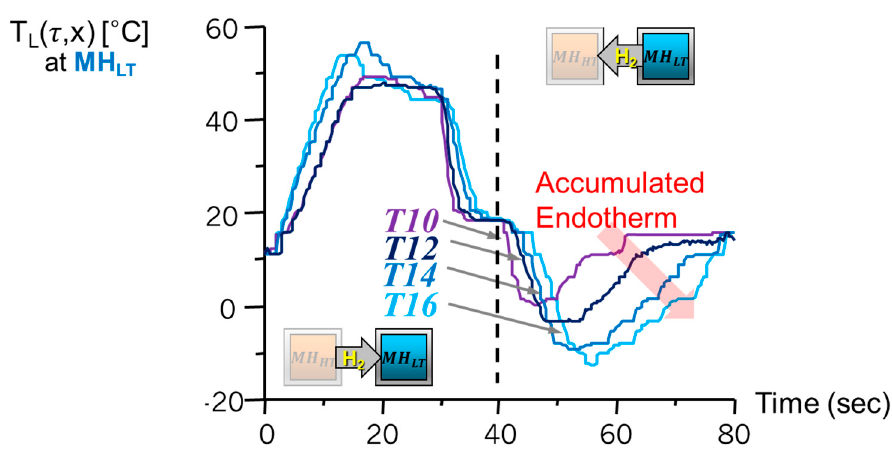
Figure 4. Metal hydride thermal energy conversion system with an arrayed dual metal hydride heat pump (MHHP) reactor pair units ( left ); the laboratory setup configuration is for the verification test of the system inducing superadiabatic TECW ( right ). Experimental results of the superadiabatic TECW is induced by deploying arrayed dual metal hydride reactor pairs in an adiabatic porous media. The temperature profiles, T1–T7, show the temperature variation over time in each location of the high-temperature channel (left), demonstrating the effectiveness of the configuration on the formation of TECW accumulating-induced heat.